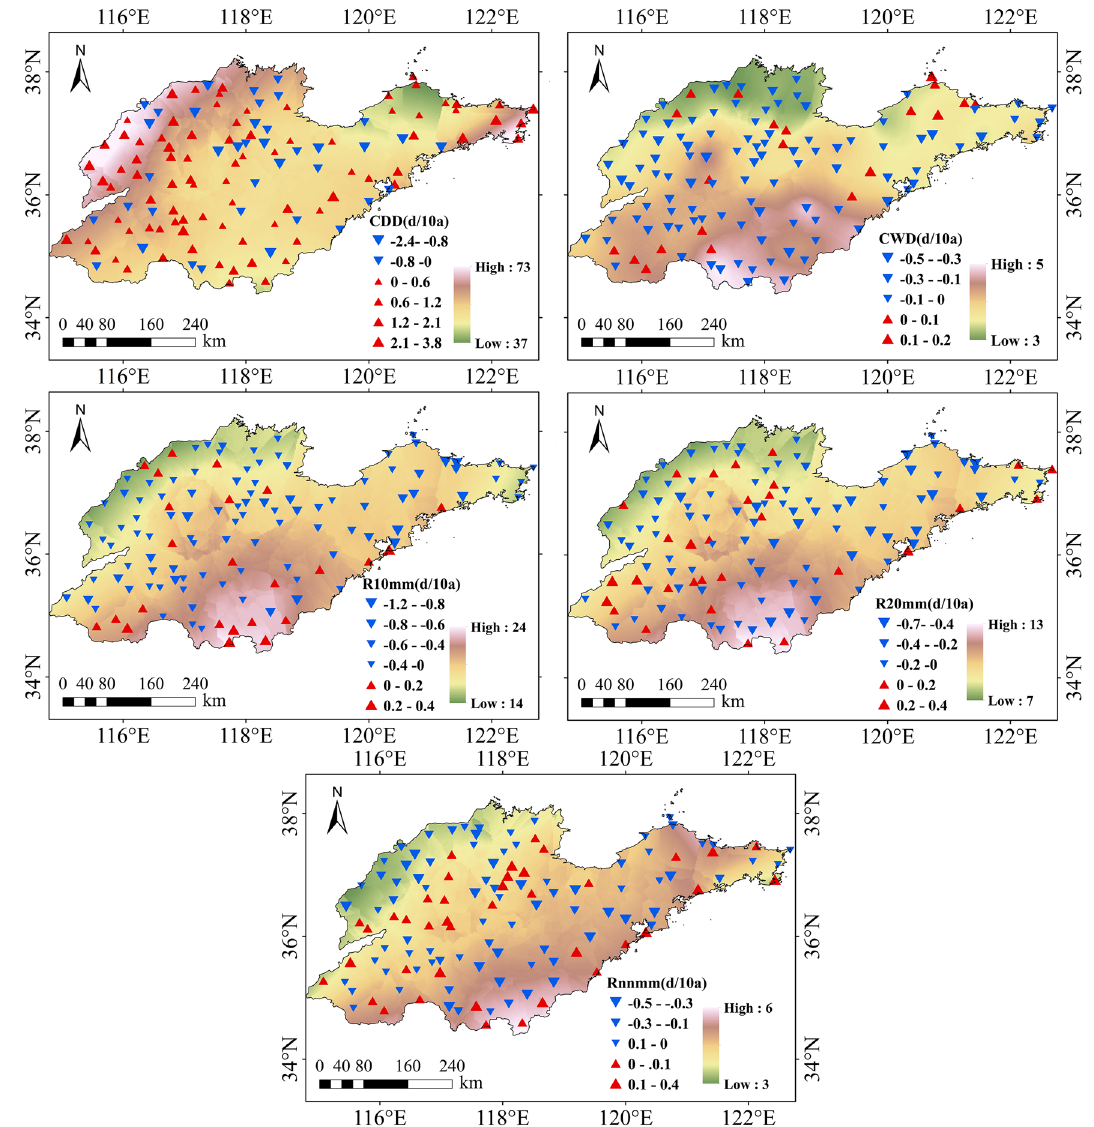
Figure 5. Mann–Kendall test and cumulative anomaly of indices related to the amount of precipitation in Shandong from 1961 to